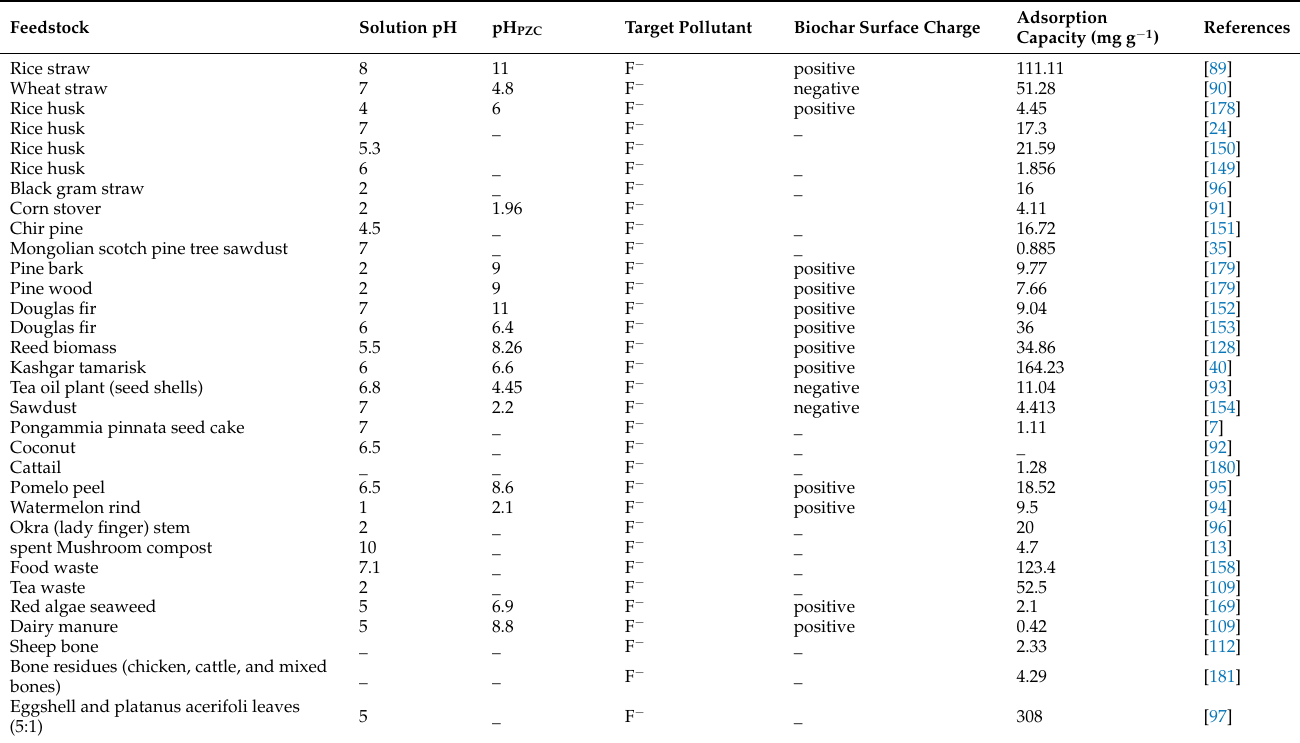
Table 3. Effect of solution pH on biochar adsorption capacity for F − removal.